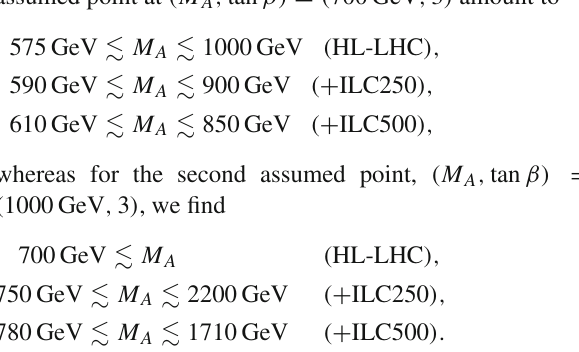
(right panel) is realized in nature. The indirect 2 σ constraints from ( ˜ χ) sce- prospective Higgs-boson signal-rate measurements at the HL-LHC and h , EFT the ILC obtained in the upper panels of Fig.12 are superimposed , tan β) = ( 1TeV , 3 ) A